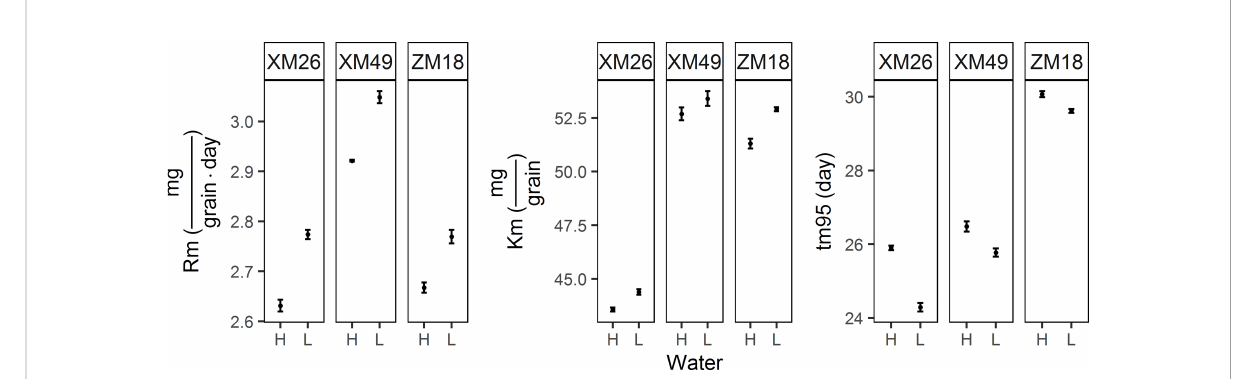
FIGURE 5 Parameters of the grain fi lling of different winter wheat genotypes under different irrigation levels. Error bars indicate the con fi dence interval of the mean. Rm, maximum rate of grain fi lling; Km, fi nal grain weight; tm95, duration of grain fi lling. XM26, Xinmai-26; XM49, Xinmai-49; ZM18, Zhoumai-18; H, high-water treatment; L, low-water